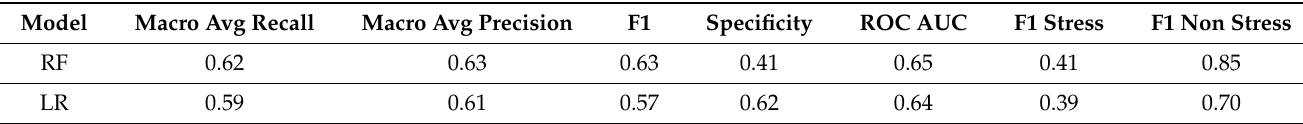
Table 7. Classification scores cross dataset